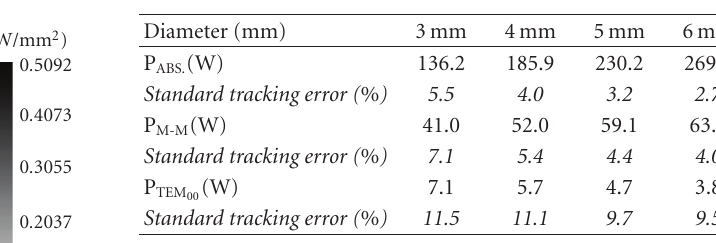
Table 2: Laser output performances and the respective standard 2mrad tracking errors for the laser rods of di ff erent diameters, pumped by the truncated